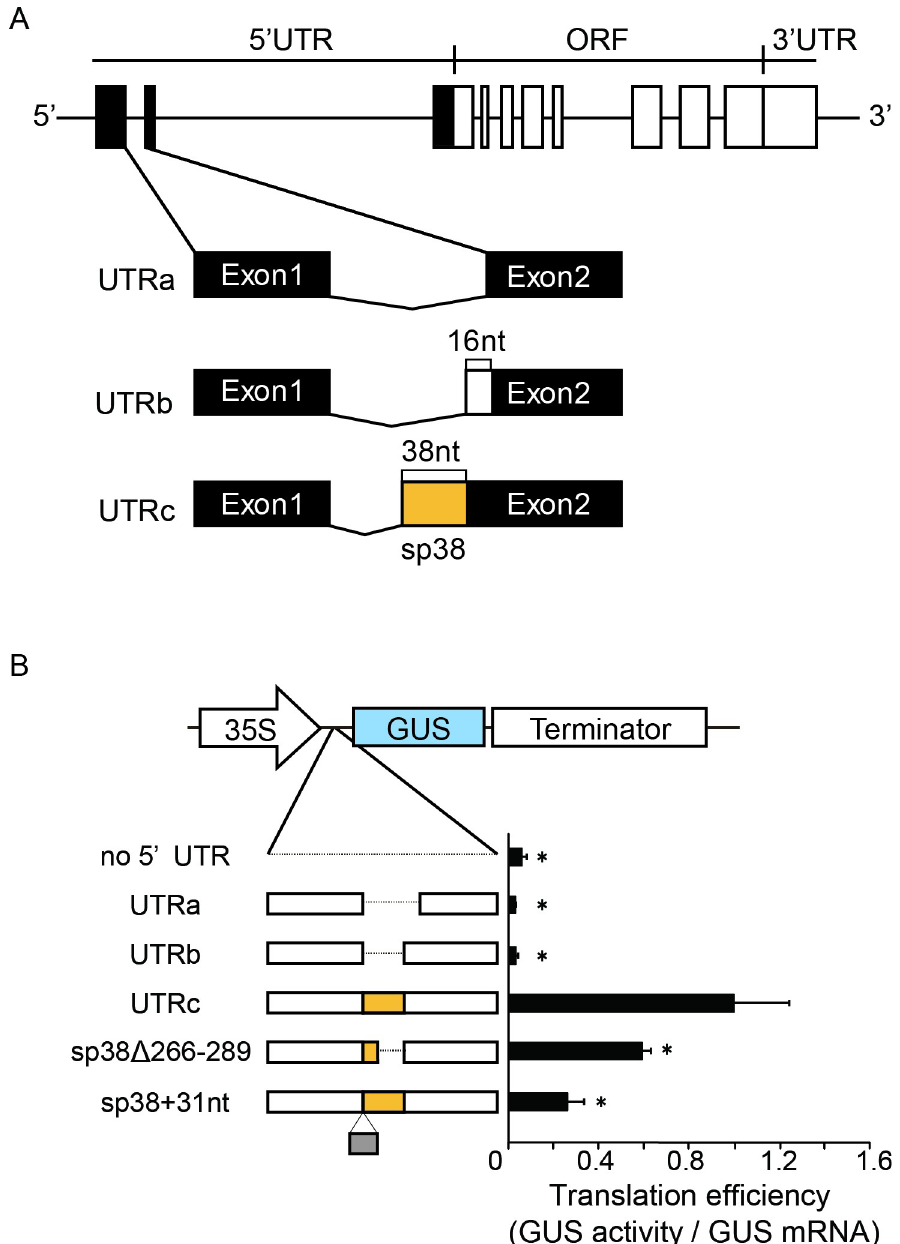
Fig 1. Structure of OsMac1 gene and the effect of the UTRc sp38 element for the translation. (A) Structure of splicing variants of the OsMac1 mRNA. Boxes show the exons. Regions corresponding to the 5’ UTR are indicated by filled boxes. Spliced regions are indicated by V-shaped lines. Differences among UTRa, UTRb, and UTRc are highlighted. "sp38" is shown as an orange-colored box. (B) Reporter assay of the UTRs. Protoplast of the rice suspension-cultured cells were transformed with the reporter gene containing UTRa, UTRb, and UTRc variants placed upstream of the GUS ORF (left panel). As the control, the region of untranslated sequence of 35S–GUS configuration derived from pBI121 (“no UTR”) was used. After transfection, the cells were incubated for 18 h, and GUS activities were determined. Right panel indicates the relative GUS activities normalized against the GUS mRNA, whose amount was estimated by real-time qRT–PCR. The value of the GUS activity with UTRc was set as 1.0. The nucleotide sequence of the additional 31 nt is shown in S1 Fig. The results represent the means of three independent experiments. Error bars indicate the SD (n = 3). Asterisks indicate significant differences in the translational efficiency of UTRc at P <